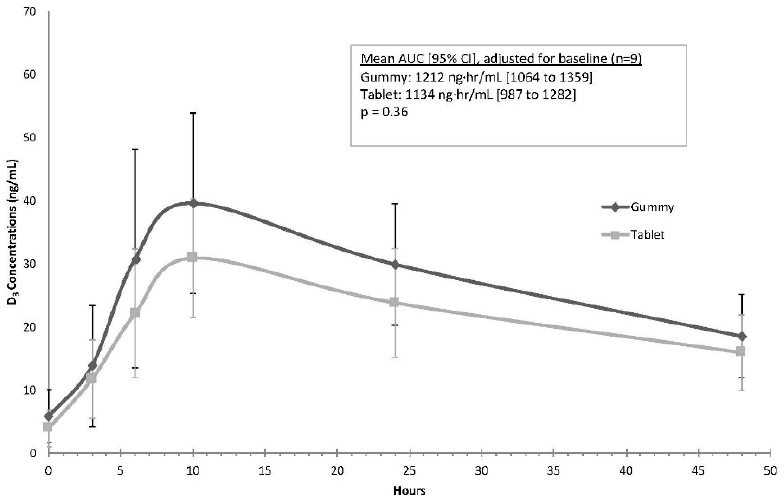
Figure 2. Time course for Study 1 of parent compound vitamin D 3 over time expressed as the mean ± standard deviation in ng/mL gummy vs. tablet preparation ( n = 9).